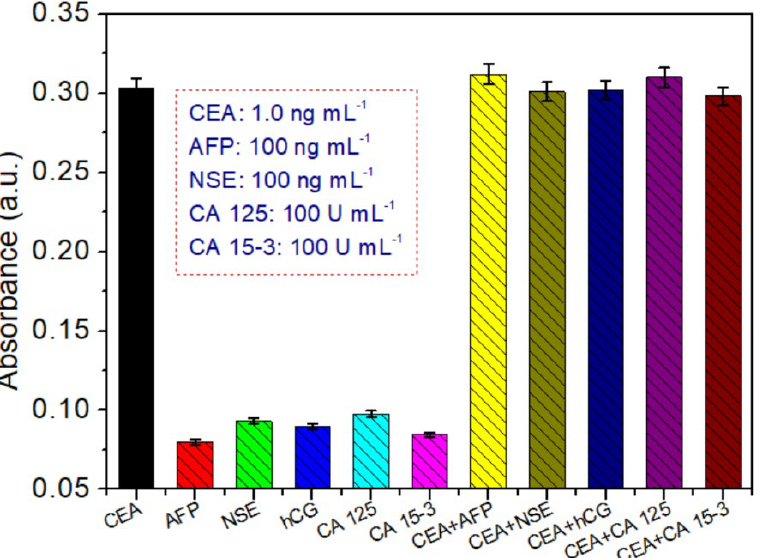
Figure 6. The specificity of the spectrometric aptasensing platform with respect to target CEA, AFP, NSE, hCG, CA 125, and CA 15-3. (Note that each data point represents the average value obtained from three measurements. The error bars represent the 95% confidence interval of the mean for y-axis concentrations.)